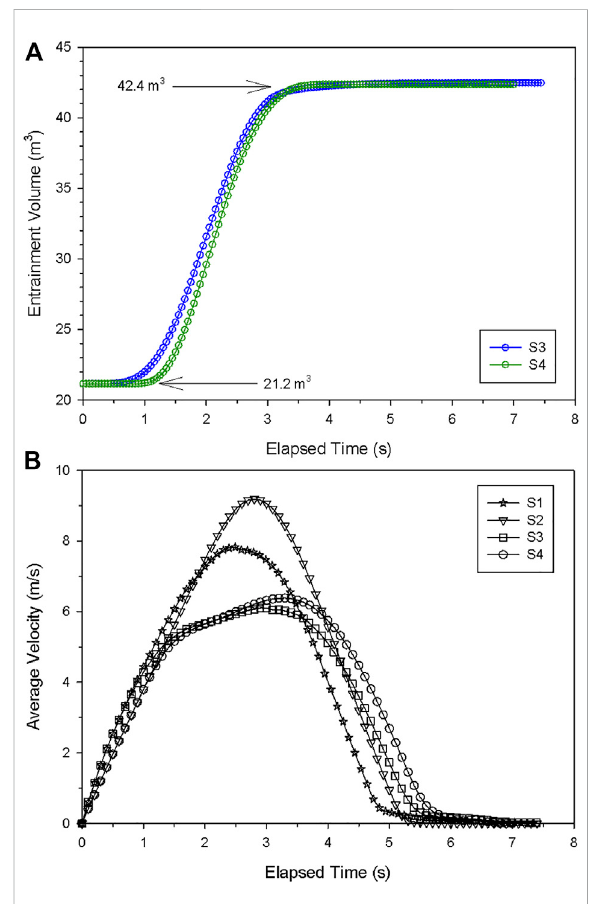
FIGURE 3 Simulated time curves of (A) the entrainment volume and (B) the average velocity of hypothetical